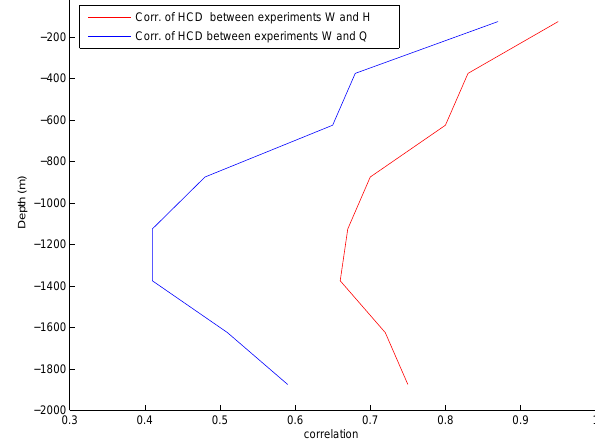
Fig. 4. Anomaly of heat content of the North Atlantic for the upper 2000m. The red, blue and green curves represent the value of the whole set, 50% and 25%, respectively. The vertical discretisation is 250m. The horizontal axes is the natural logarithm of the absolute value of the HCD in Joules.